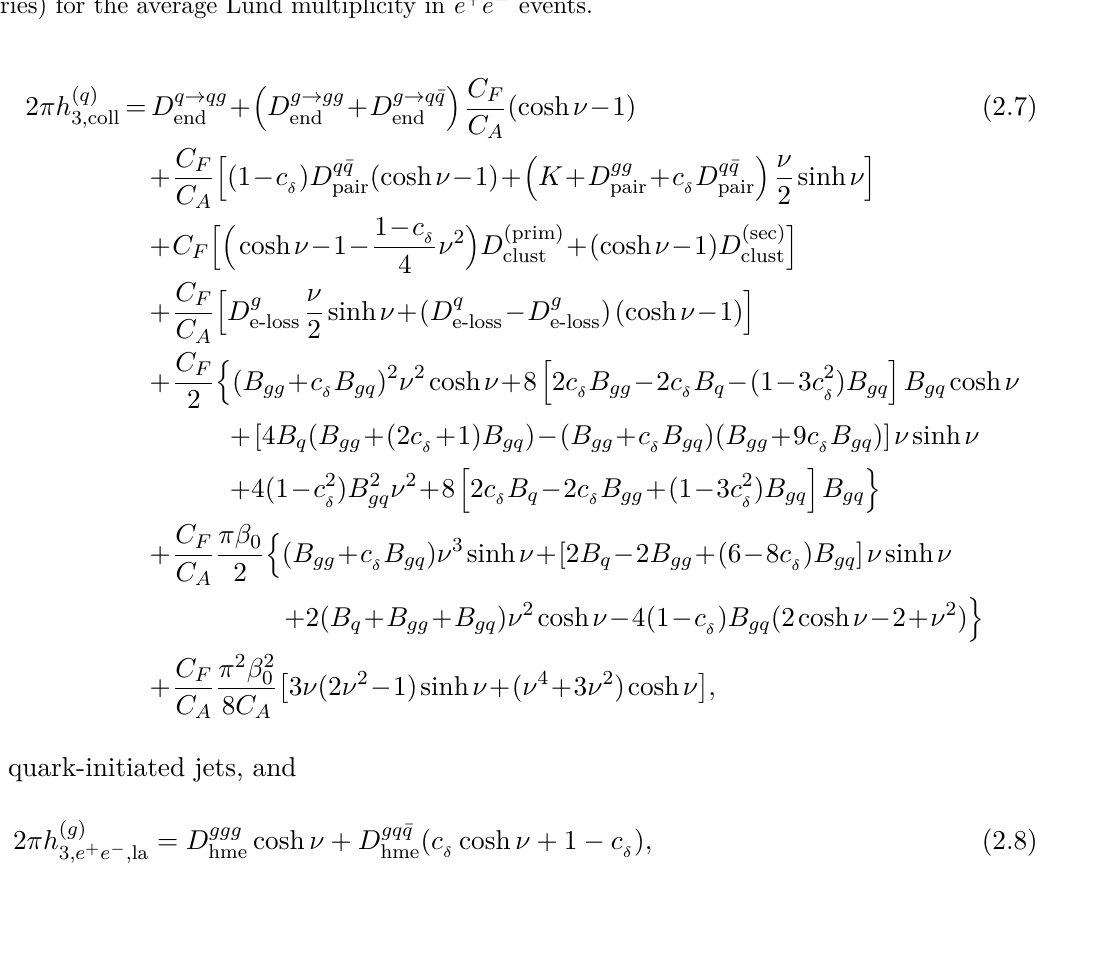
Table 1 . Coefficients entering the NDL h entries) for the average Lund multiplicity in e + e −